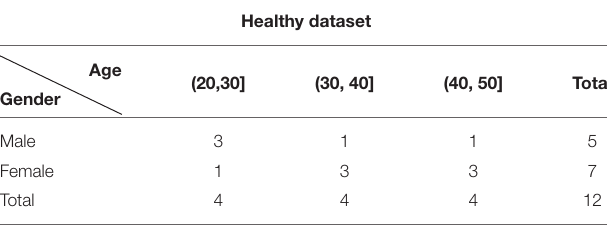
TABLE 1 | The age and gender distribution of the healthy